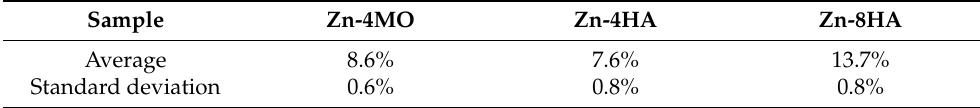
Table 4. Theoretical porosity of the materials.